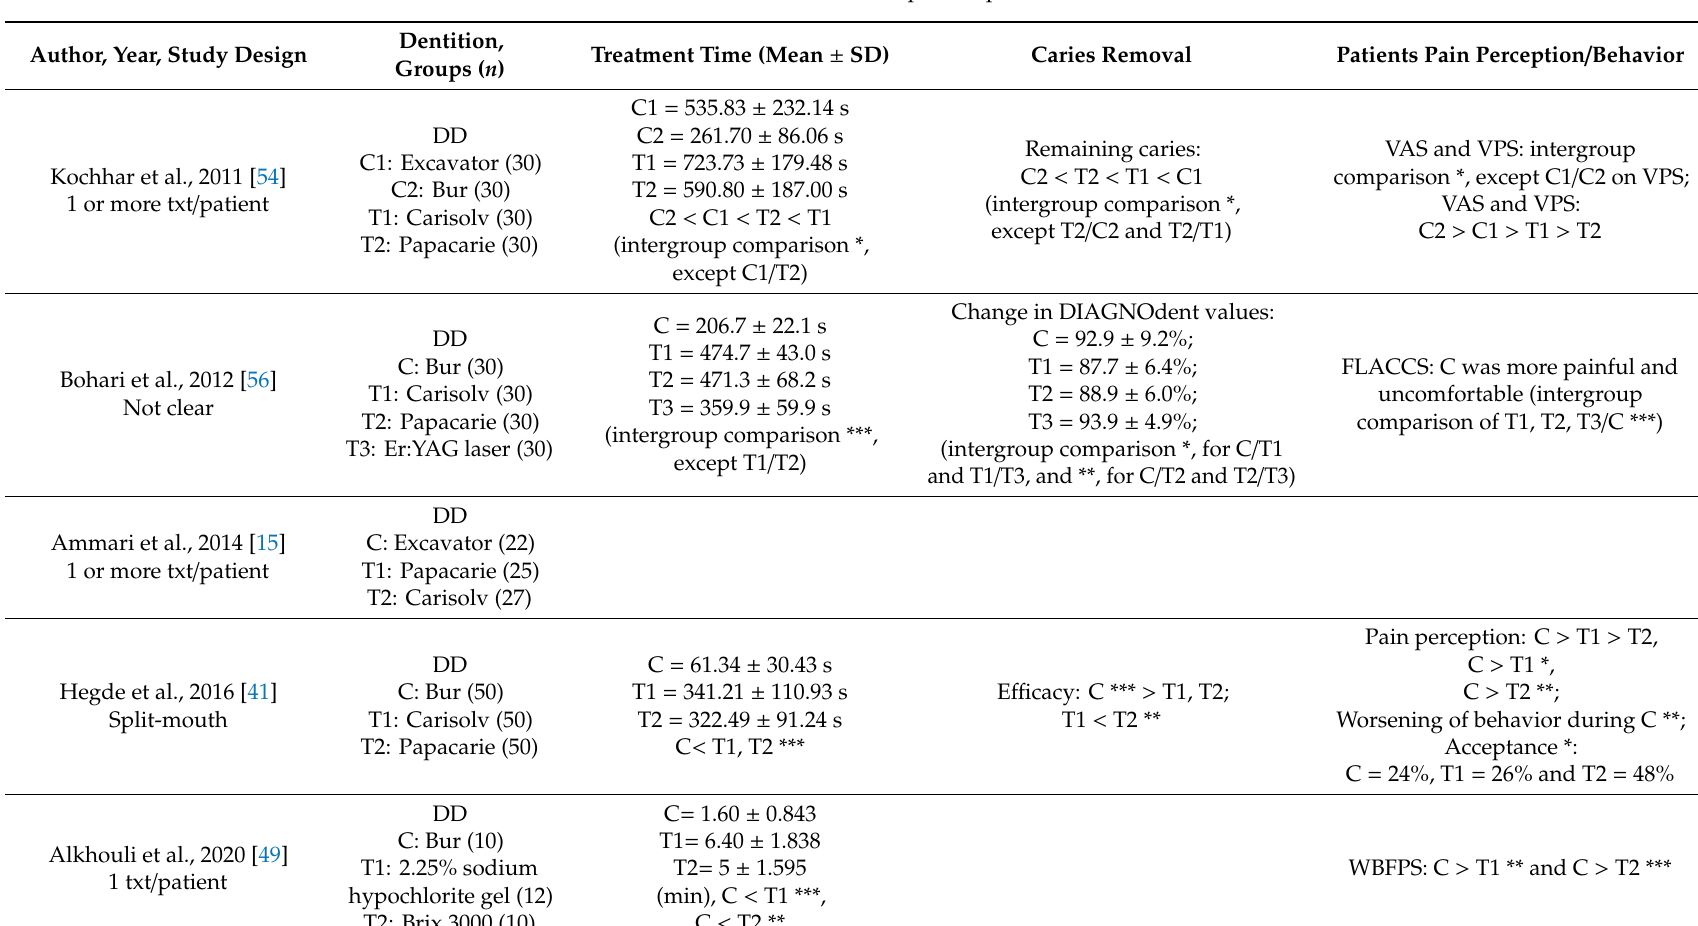
Table 6. Studies with multiple